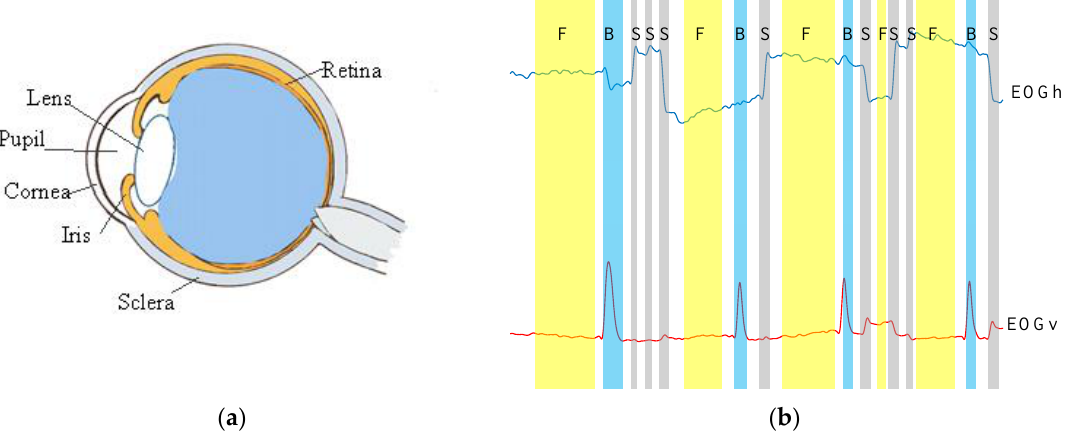
EOG ) and vertical ( EOG ) signal h v